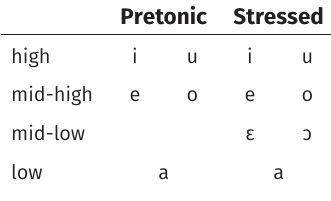
Table 1: BP vowel inventory in pretonic and stressed syllables (adapted from Camara Jr. 1977: